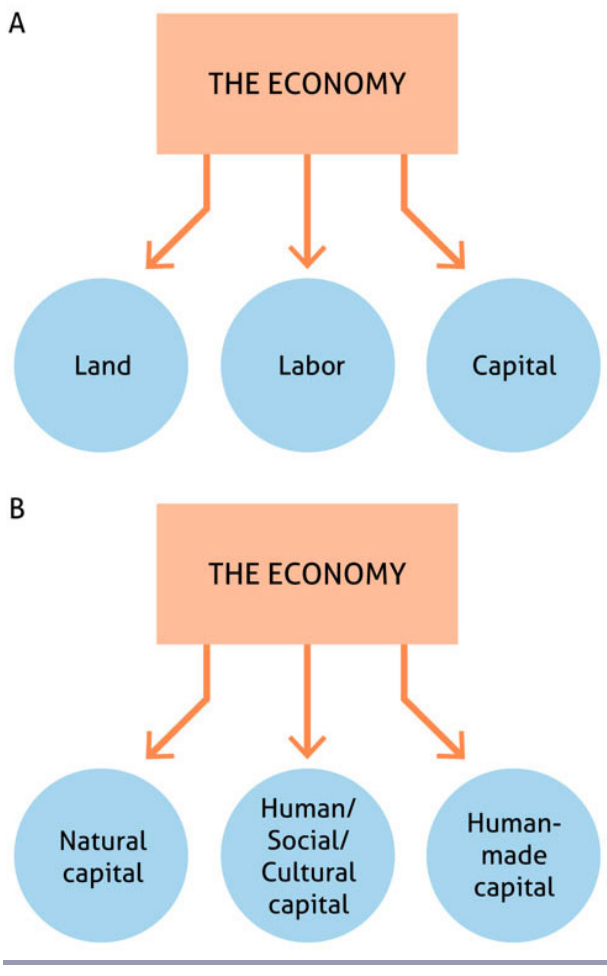
Fig. 1 . Factors of production of an economy. (A) The classical factors of production in economics, land, labor, and capital and (B) their extension into natural capital, human/social/ cultural capital, and human-made capital, emphasizing complementarity (e.g., Costanza and Daly 1992, Berkes and Folke 1992).